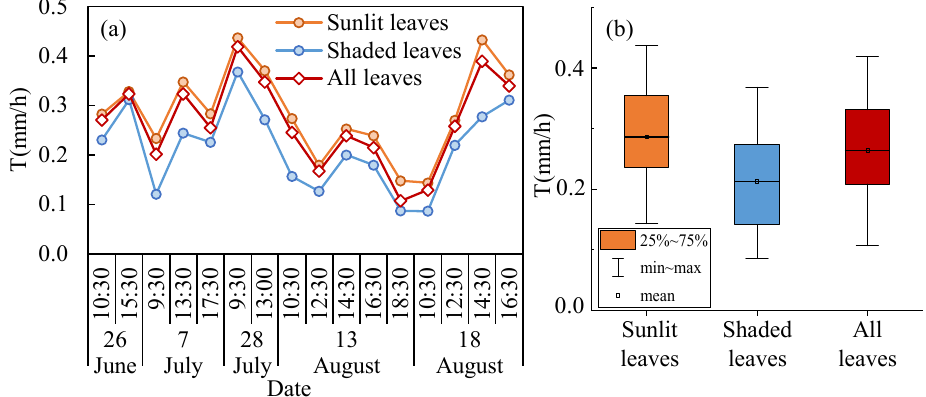
Figure 11. ( a ) Diurnal variations of transpiration rate of grape; and ( b ) the basic statistics of transpiration rate under sunlit leaves, shaded leaves, and all leaves.